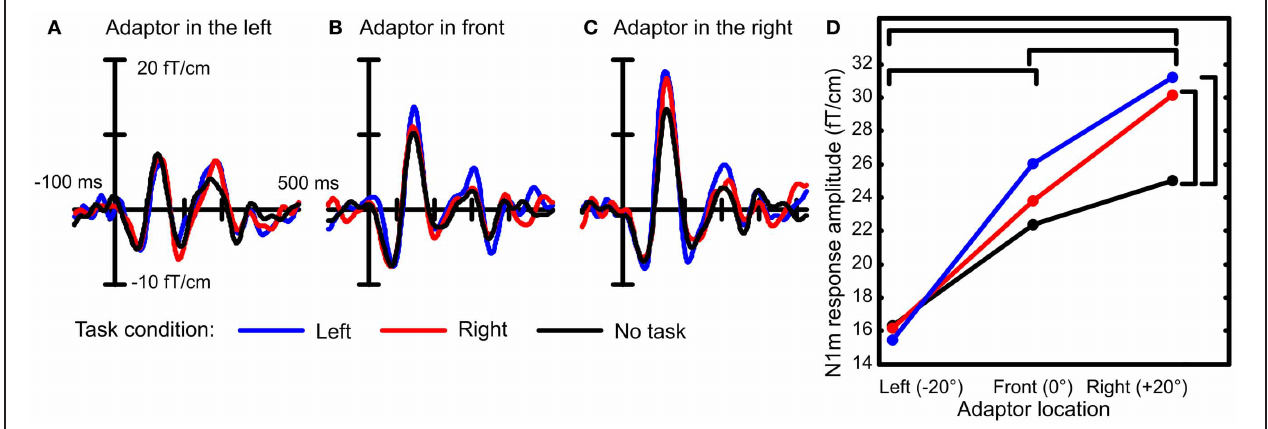
between the probe and the adaptor, larger responses to the probe were recorded during the visual task conditions than when no task was performed ( B and C ). Therefore, the increase in N1m response amplitude to the probe was larger during the visual task condition than when the subject was not engaged in a task (D) . This suggests that the spatial selectivity of auditory cortical neurons was enhanced during the performance of the visual task. Statistically significant differences are marked with